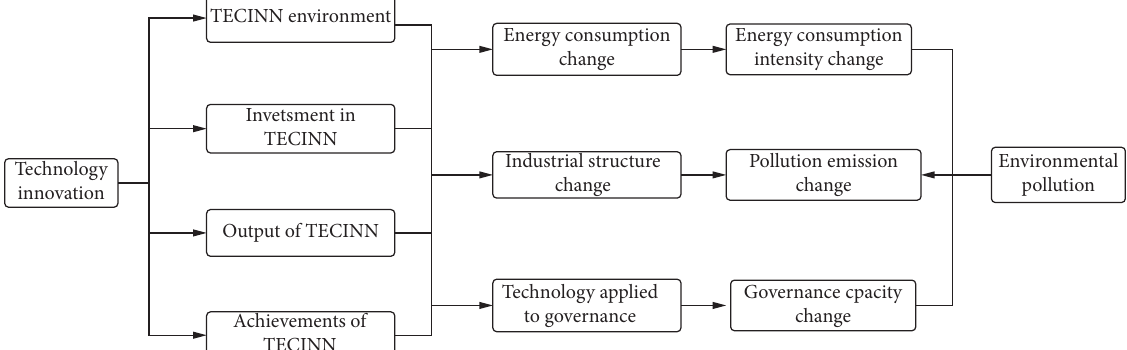
Figure 1: The influence mechanism of technological innovation (TECINN) on environmental pollution.